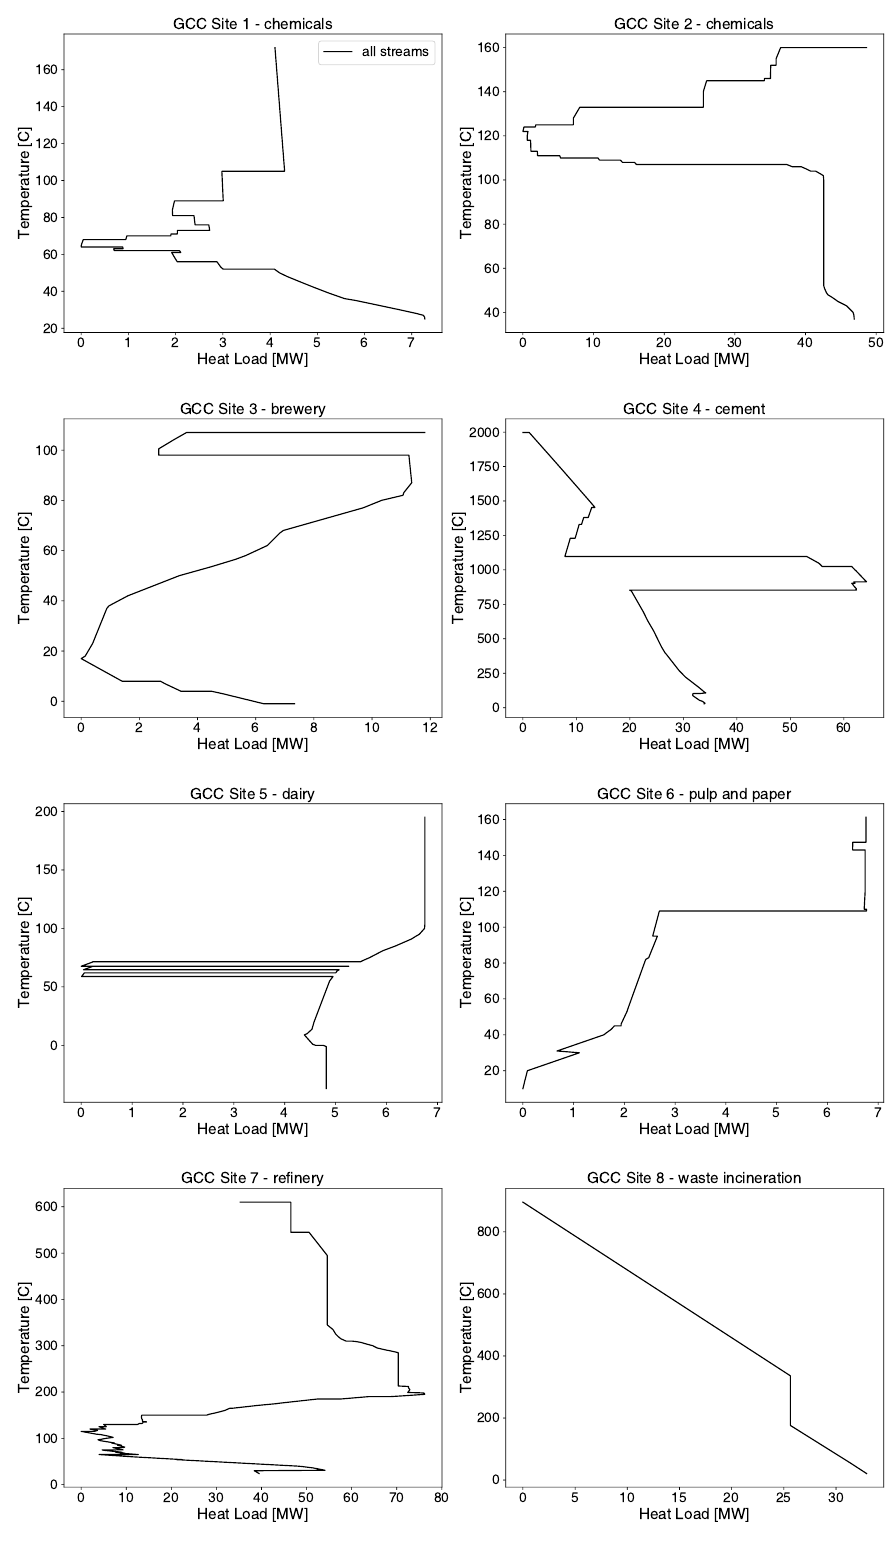
Figure A1. GCCs of the industrial processes in the case